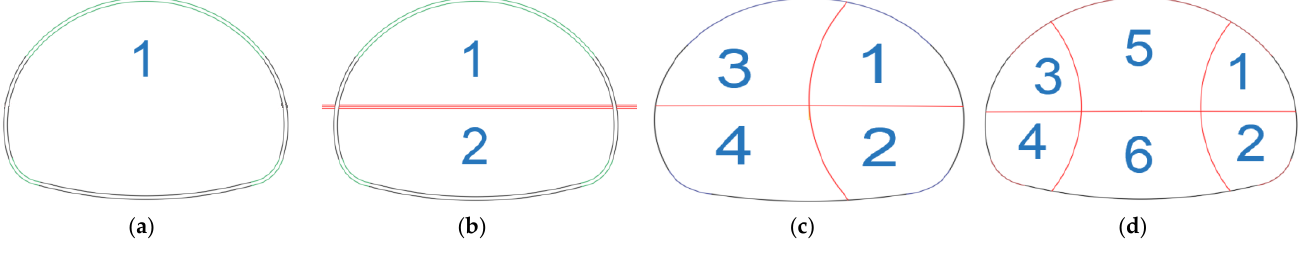
Figure 2. Face division of each excavation scheme: ( a ) Full section method; ( b ) Step method; ( c ) CD method; ( d ) Double wall heading method. Table 1. Research section support parameters.